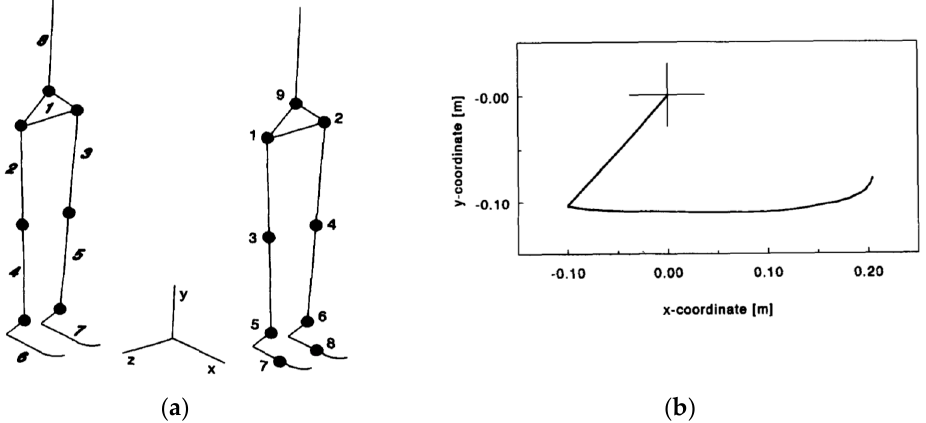
Figure 2. The eight segments human body model ( a ) with experimentally measured foot shape; ( b ) used by Koopman et al. [35].